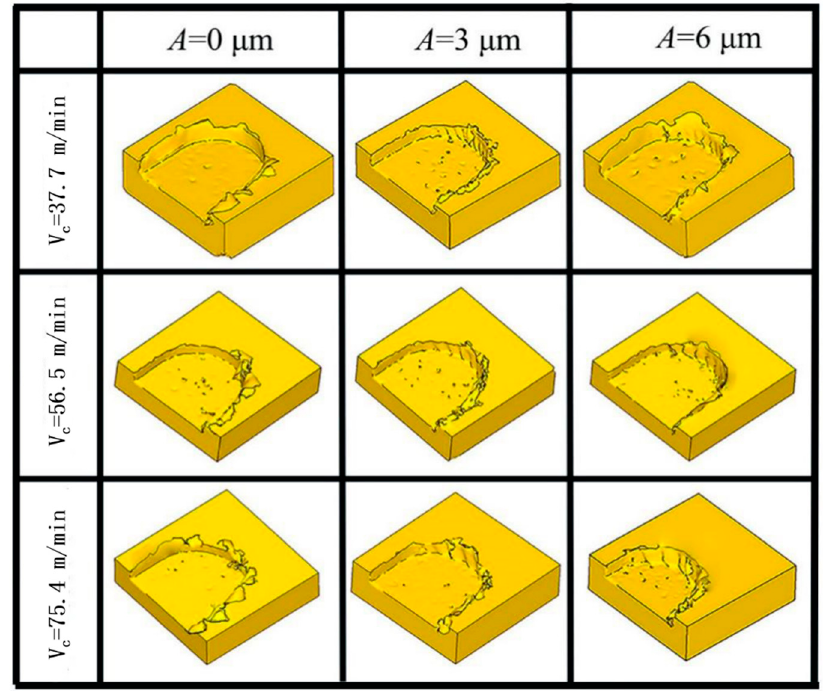
Figure 11. Burr morphology ( a , b ) TMM; ( c , d ) UVAMM. (2) Effect of ultrasonic vibration on burr formation at different V c .